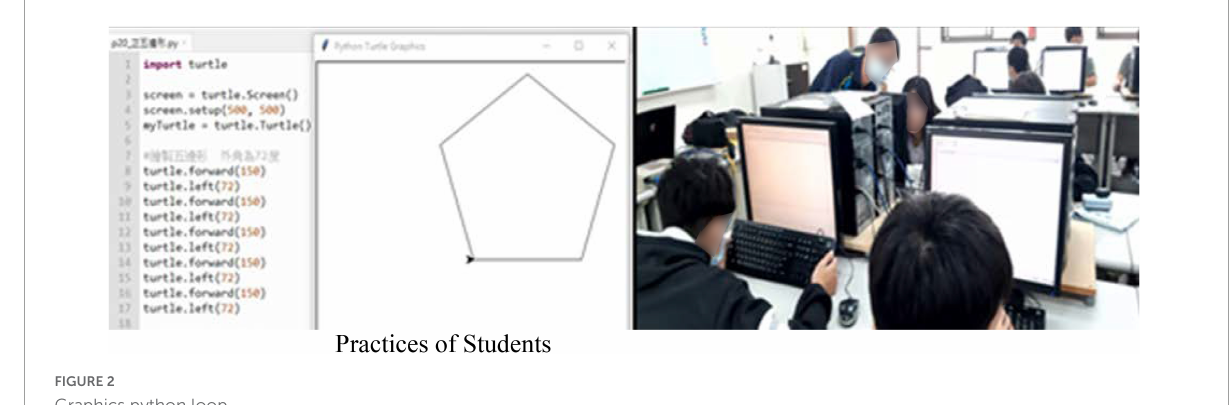
FIGURE2 Graphics python loop.